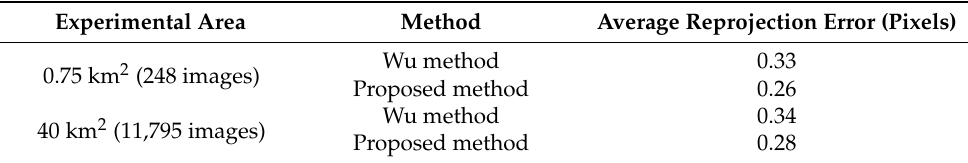
Table 4. Statistical results of the average reprojection